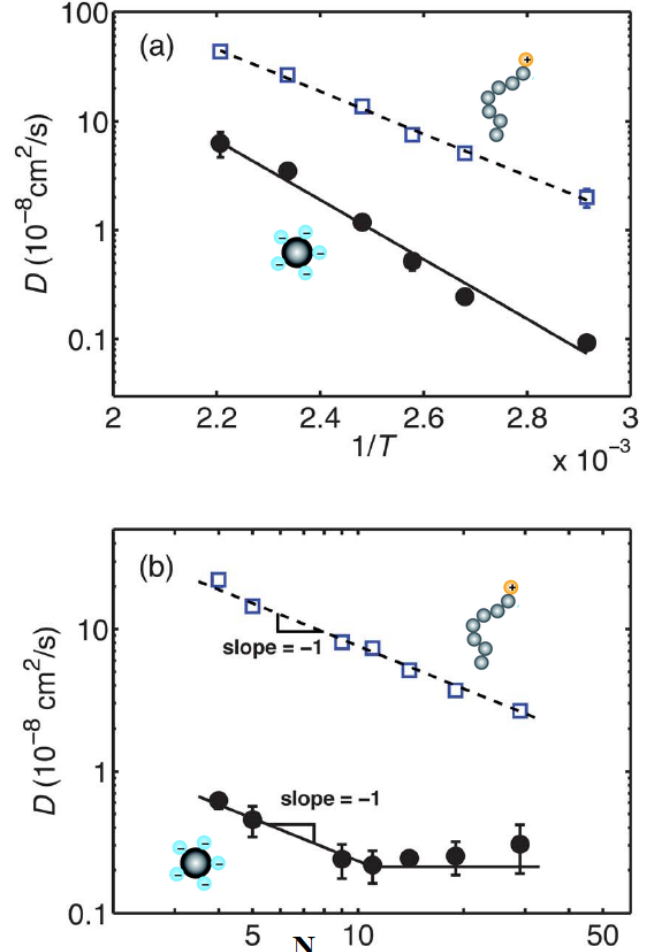
Figure 17. Self-diffusion coefficients of the cores (solid circles • ), and chains (open squares (cid:3) ) as functions of ( a ) inverse temperature for chain length N = 14, and surface beads on the core g = 8; ( b ) chain length N at T = 100 °C with g = 8. Solid and dashed lines in ( a ) are Arrhenius expressions fitted to the cores and the chains, respectively. The dashed line in ( b ) is fitted to the Rouse model and the solid line to the theory of Ref. [145]. Reprinted and enhanced by thumbnails with permission from Hong and Panagiotopoulos